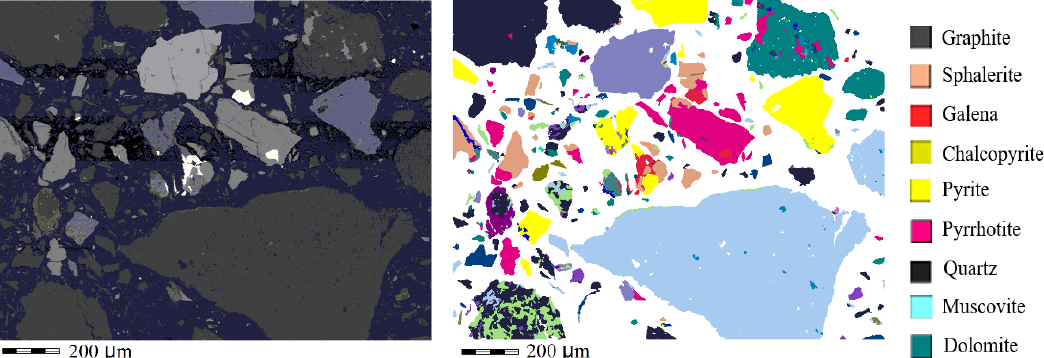
Figure 5. Mineral distribution in the lead–zinc mine.